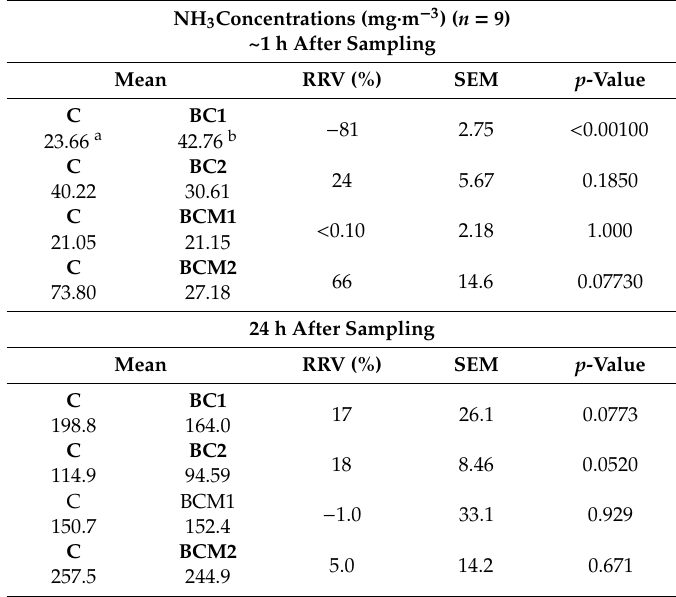
Table 5. Mean ammonia concentrations in treated excreta